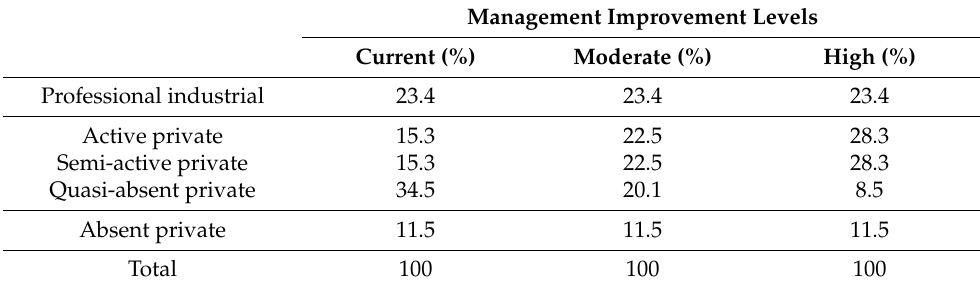
Table 2. Management improvement levels expressed by forest area percentages by owner